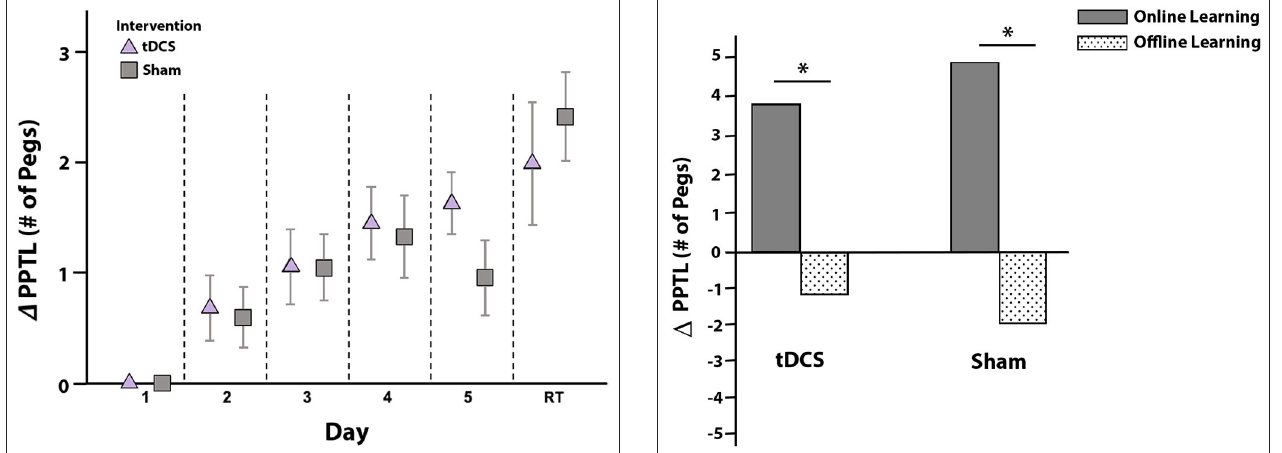
FIGURE 3 | Motor learning by intervention group. Mean daily change in PPT L scores from baseline (y-axis) are shown for the active (triangle) and sham (squares) intervention groups. Error bars represent standard error. In both groups, scores improved from baseline to post-intervention testing on day 5, with no skill decay at retention testing (RT) 6-weeks post-intervention. No between group differences in PPT L scores were noted at any timepoint. 1 PPTL: change in left-hand Purdue Pegboard Test scores from baseline.